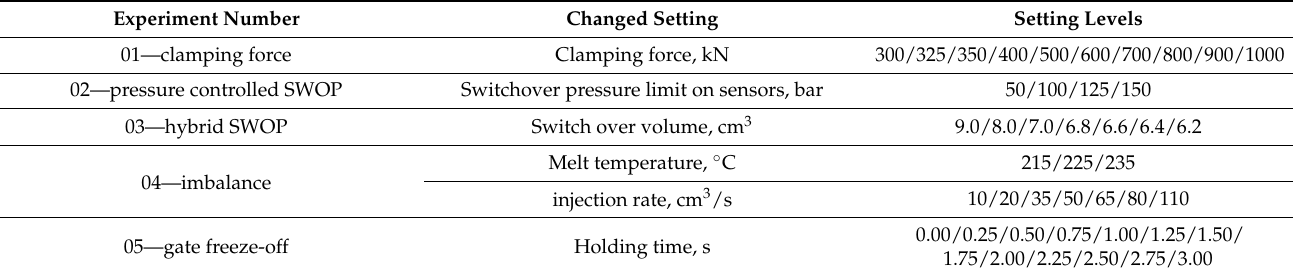
Table 3. Injection molding parameters—variable parameter